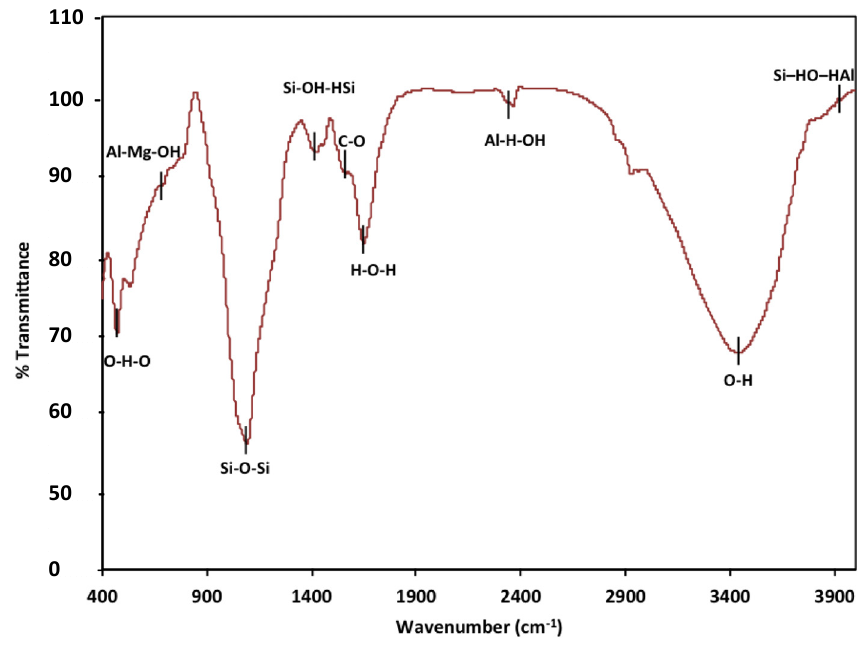
Figure 3. The FIR spectrum of the alum sludge granulated bed in constructed wetland systems.